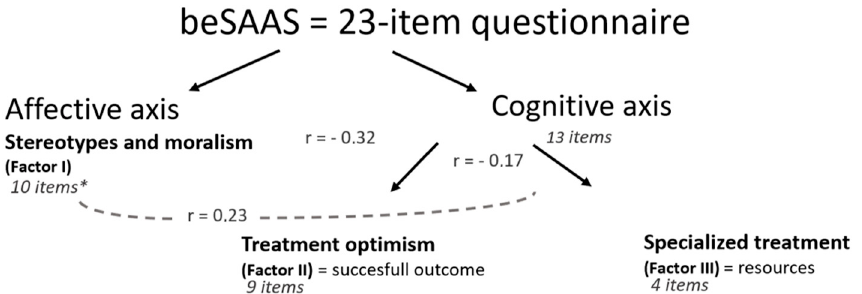
Figure 1. Factor structure of the beSAAS questionnaire according to the number of items characterising each factor * and correlations between scores derivated from these factors (r).